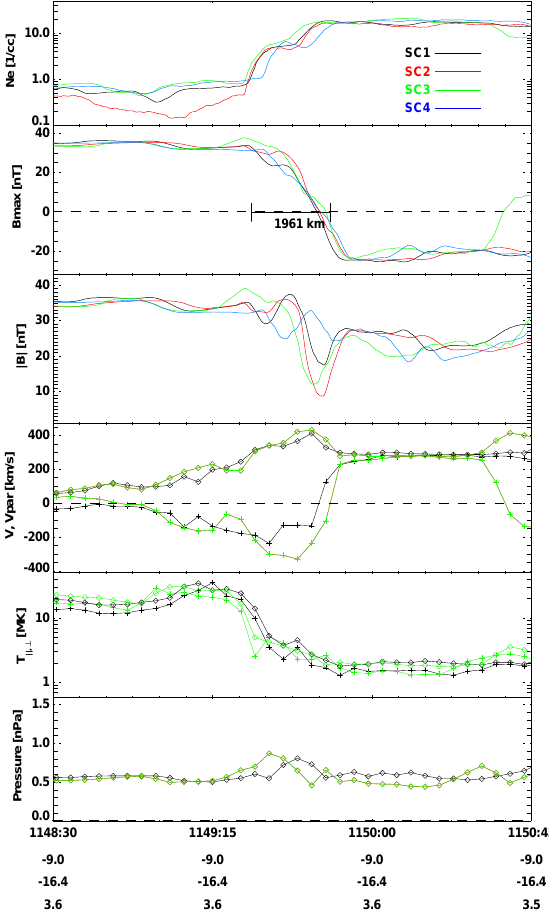
Fig. 9. Plasma and magnetic field data for the crossing at 15:26 UT on 5 July 2001. Plot format and labelling as in Fig. 4. Note the density plateau on the magnetospheric side of the